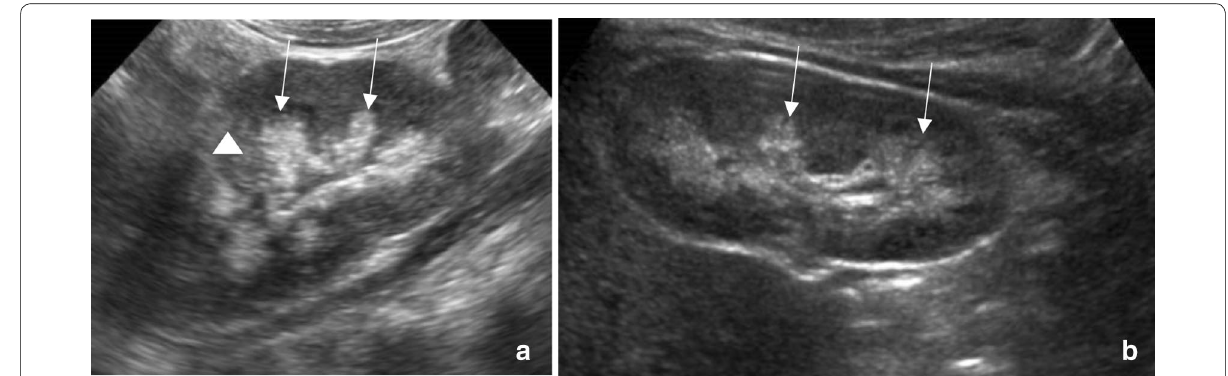
Fig. 5 Nephrocalcinosis: a Right kidney: Ultrasound of the right kidney showing hyper‑echogenicity of the renal pyramids with coarse echotexture (long thin arrows). There is no associated posterior acoustic shadowing seen. Loss of cortico‑medullary differentiation (arrowheads) can also be seen. b Left kidney: Ultrasound of the left kidney showing hyper‑echogenicity of the renal pyramids with coarse echotexture (long thin arrows)